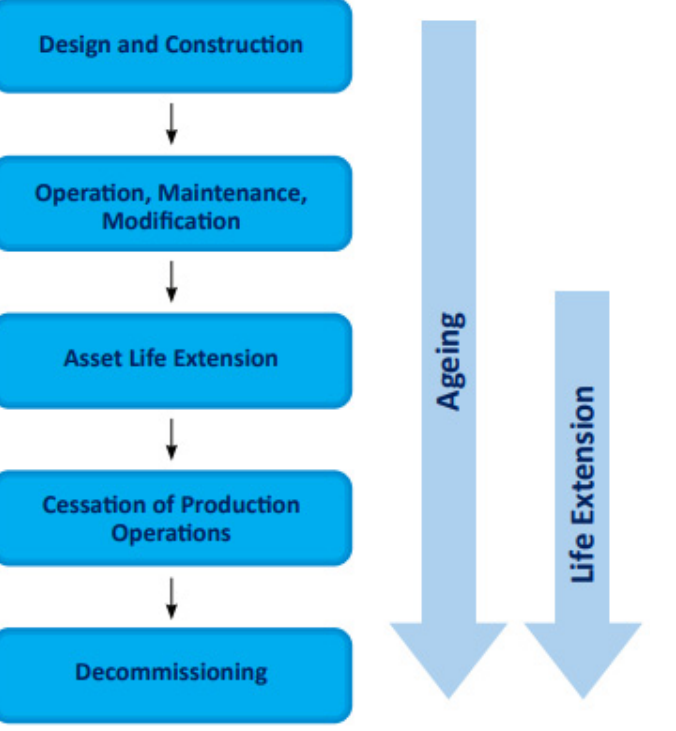
Figure 4. An illustration of the aging life cycle. (This image is re-used/reproduced with permission of the Oil and Gas UK. Publishers: OGUK & OEUK, Copyright year: 2012, Source: [209]). of the Oil and Gas UK. Publishers: OGUK & OEUK, Copyright year: 2012, Source: